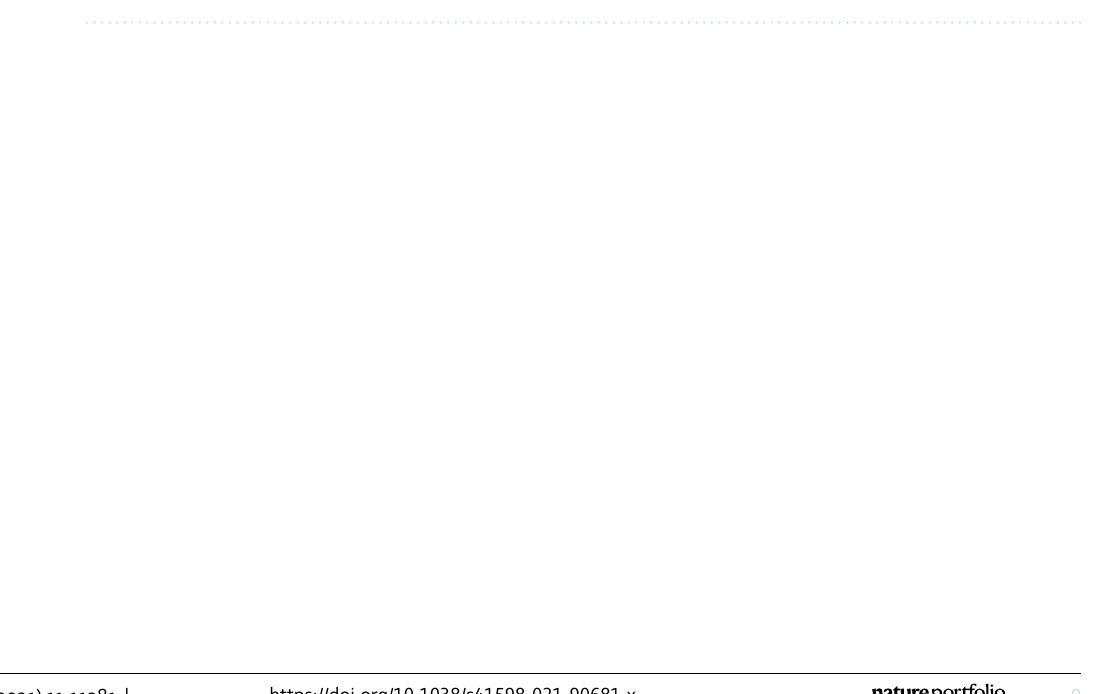
Figure 8. Examination of heart anatomy. ( A – C ) A single ventricle and bilateral trefoil-shaped lungs were